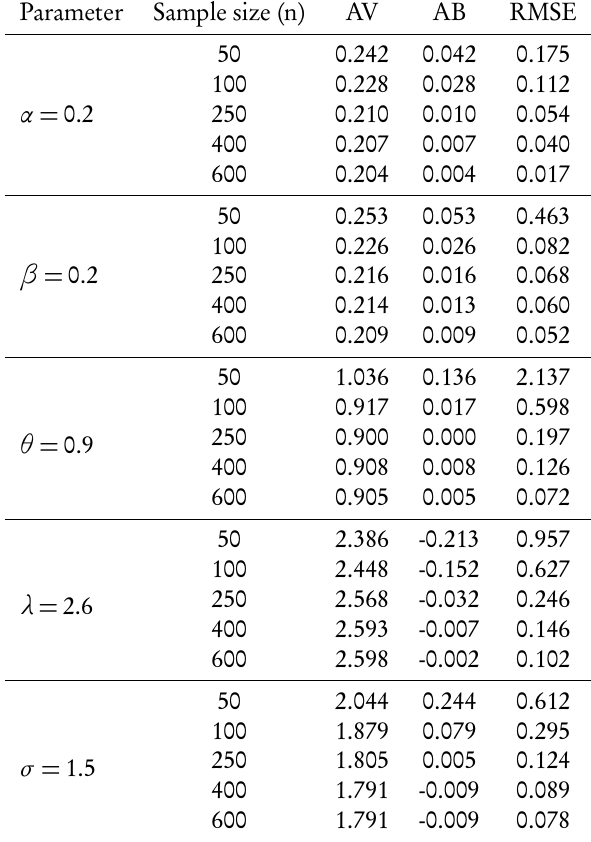
Simulation results for ( α , β , θ , λ , σ ) = ( 0.2,0.2,0.9,2.6,1.8 )